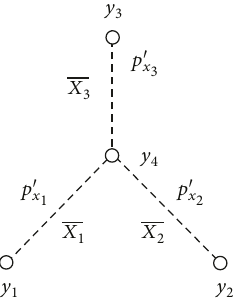
Figure 8: Illustration of three SVI terms with a common